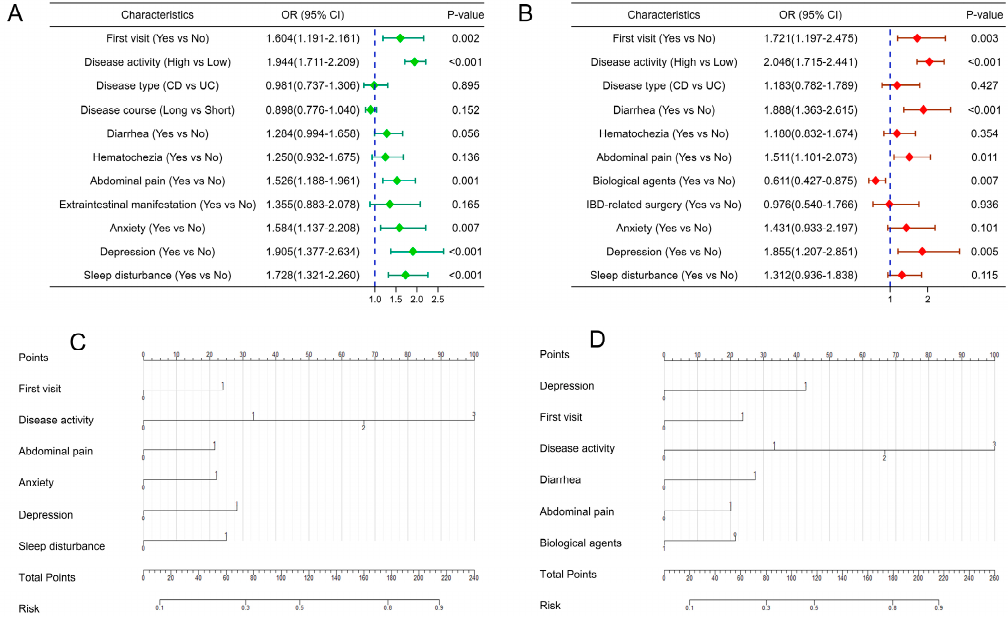
Figure 2. Forest plots ( A , B ) of independent influencing factors and establishment of nomogram models ( C , D ) for predicting quality of life in IBD patients of different genders (( A , C ): males; ( B , D ): females). (Disease activity: 0 = Remission, 1 = Mildly active, 2 = Moderately active, 3 = Severely active. Other variables: 0 = No, 1 = Yes; IBD: inflammatory bowel disease; UC: ulcerative colitis; CD: Crohn’s disease; OR: odds ratio; CI: confidence interval).